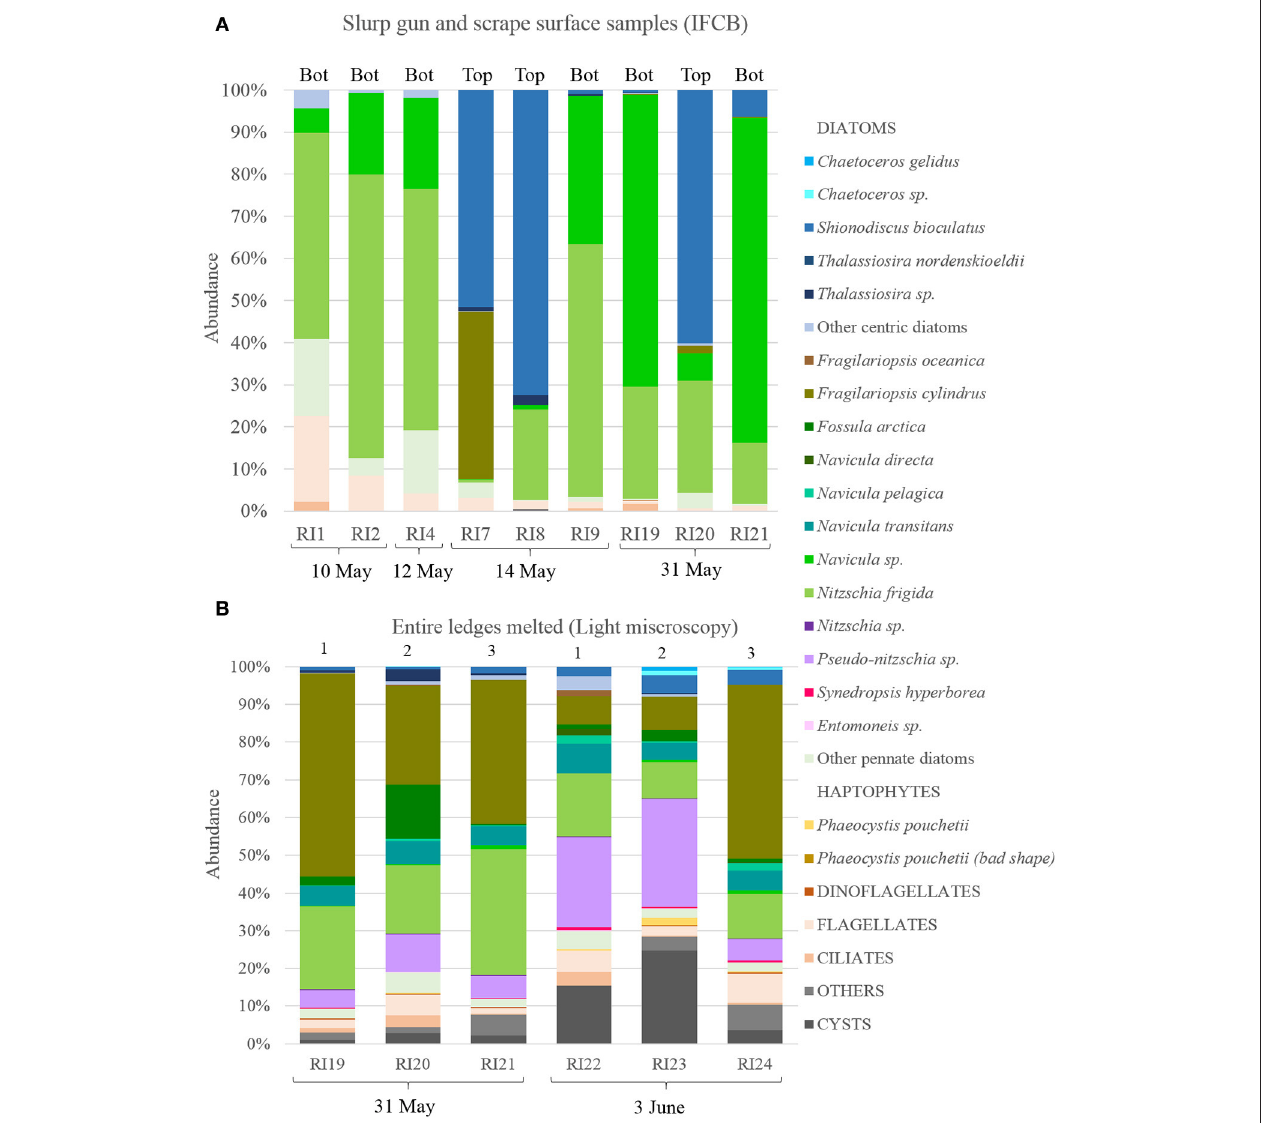
FIGURE 6 | Relative composition of ridge communities (A) Surface of the ice ledge samples collected with the slurp gun or by coring and then scraping the bottom (Bot) or top (Top) of the ice core. Samples analyzed with the imaging FlowCytoBot (IFCB). (B) Entire ledges melted. Numbers at the top correspond to the order of the ledges from top to bottom and the dates of sampling are indicated below. Samples analyzed by light microscopy enabling a higher taxonomic resolution.